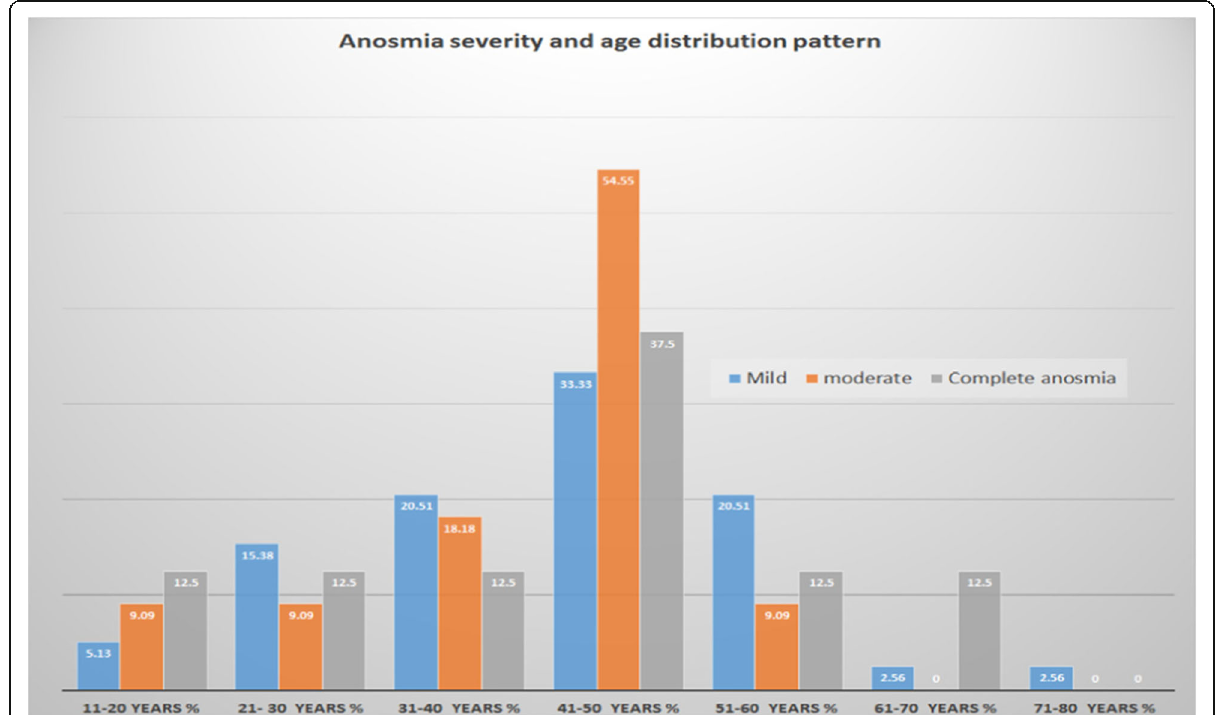
Fig. 2 The percentage of smell loss severity in the different age groups